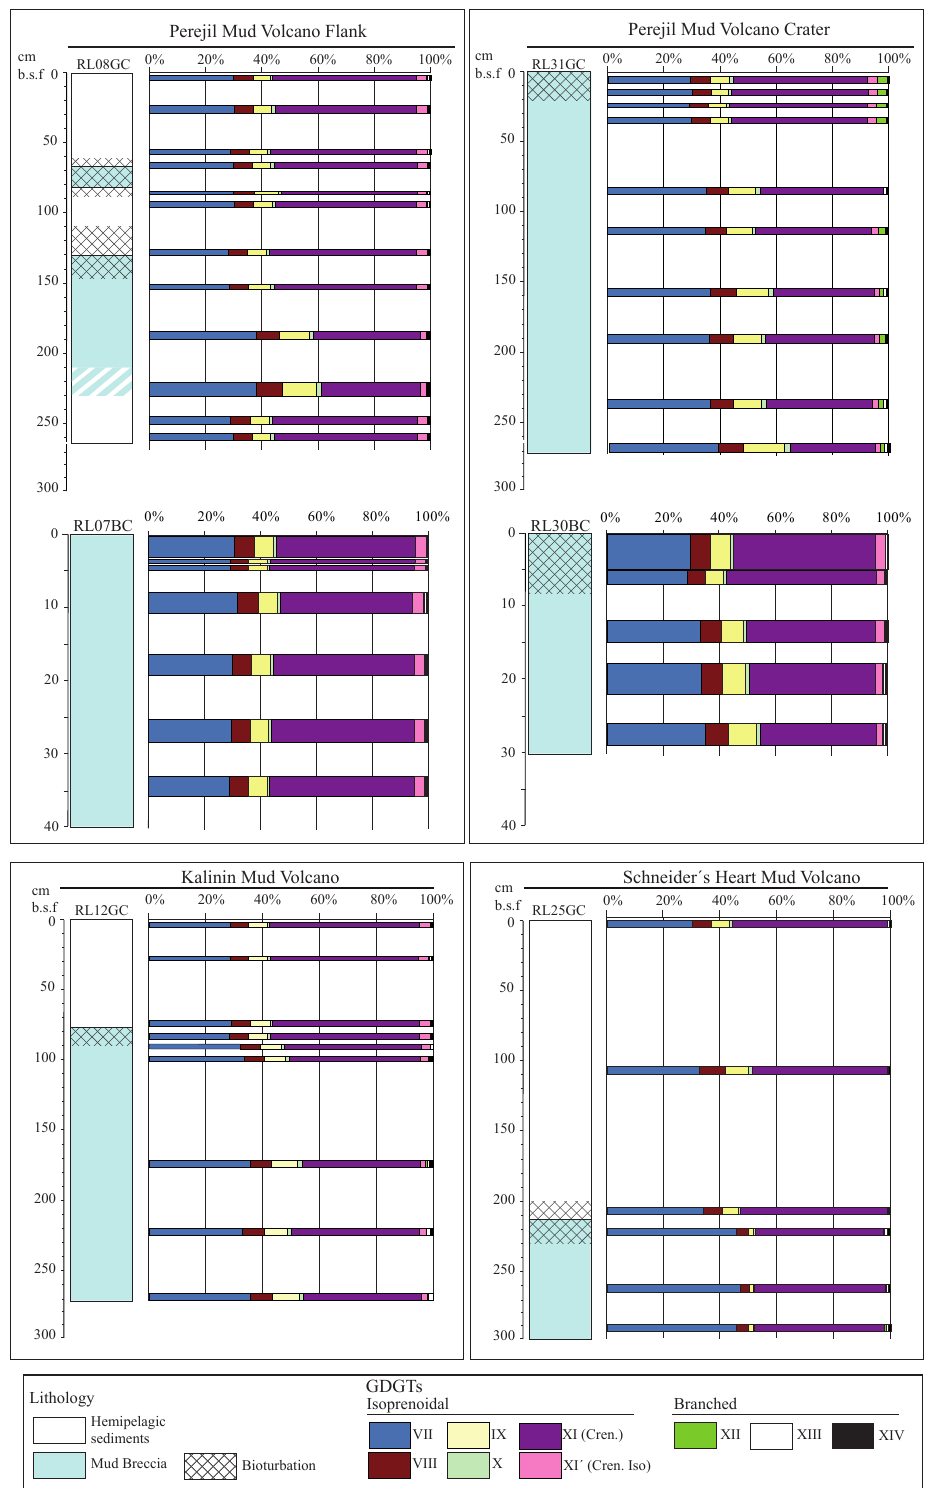
Figure 6. Fractional abundance (%) of isoprenoidal and branched GDGTs for Perejil MV crater and flank and Kalinin and Schneider’s Heart MVs. For GDGTs structures see